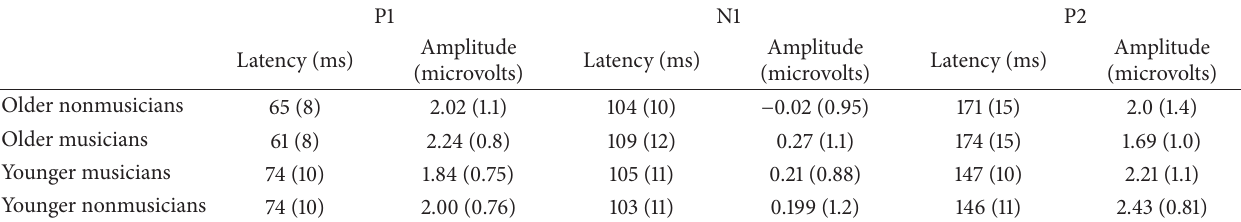
Table 3: Mean and standard deviation values for P1-N1-P2 cortical auditory evoked potential latencies and amplitudes elicited by standard harmonic tone ( 𝐹0 = 392 Hz) from older and younger musicians and nonmusicians.